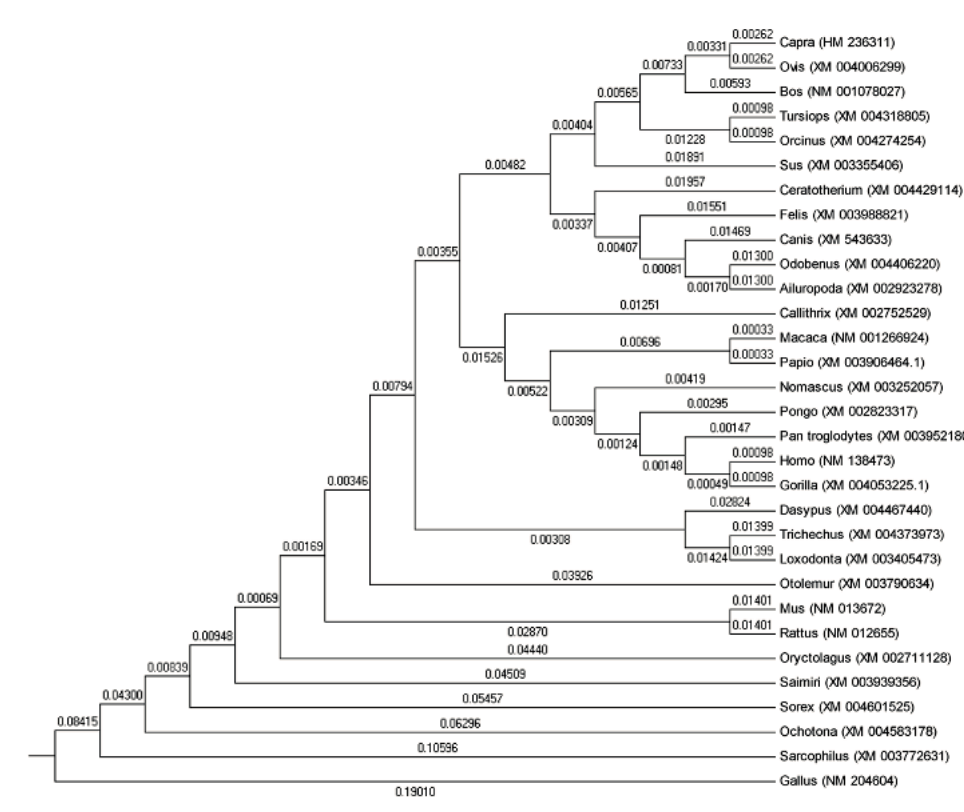
Figure 2. Phylogenetic tree based on SP1 gene sequences of 31 representative animals made with MEGA 5 software (S. Kumar, Tempe, AZ, USA) using Neighbor-Joining (NJ)